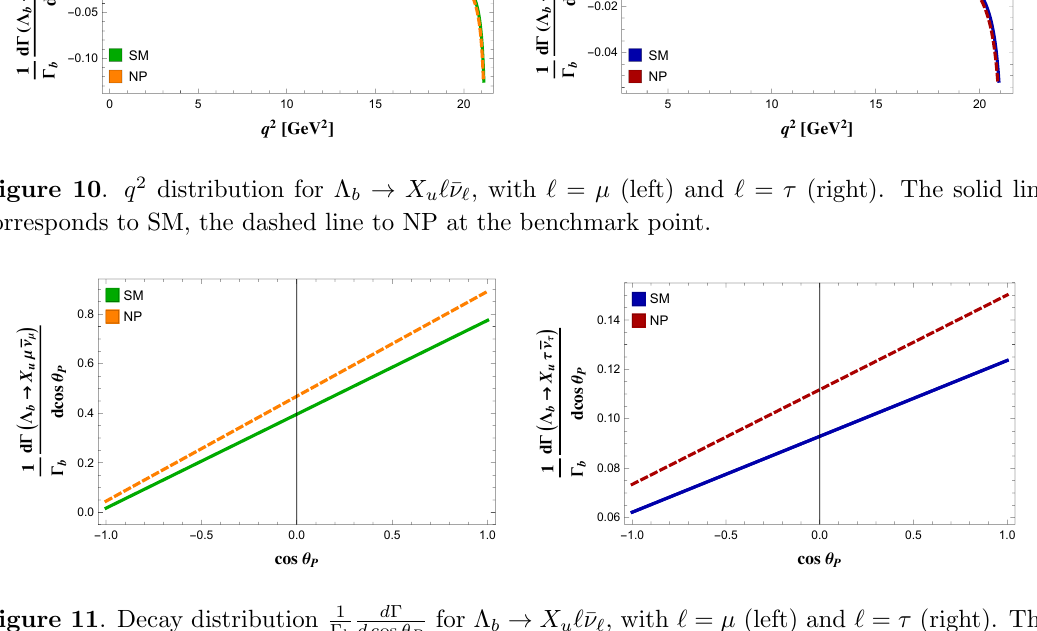
Figure 11 . Decay distribution 1 solid line corresponds to SM, the dashed line to NP at the benchmark